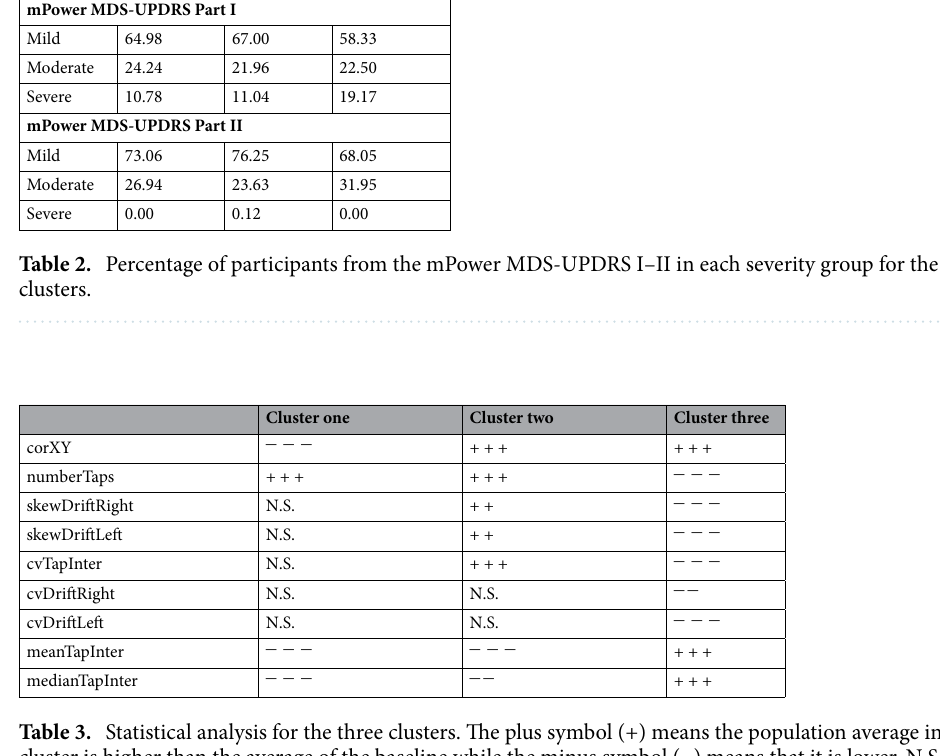
Table 3. Statistical analysis for the three clusters. The plus symbol (+) means the population average in a cluster is higher than the average of the baseline while the minus symbol (−) means that it is lower. N.S. means there is no statistical difference. The number of markers means the p value is less than 0.05, 0.01, and 0.001, respectively.